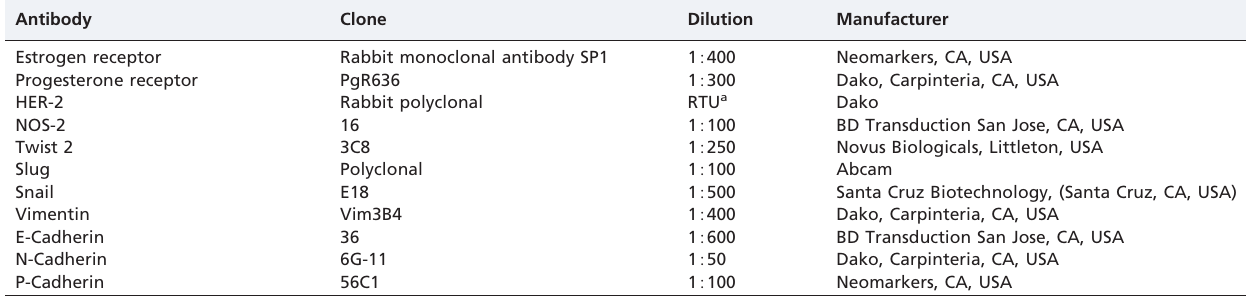
Table 1 - Antibodies and protocols used in the reactions. Antibody Clone Dilution Manufacturer Estrogen